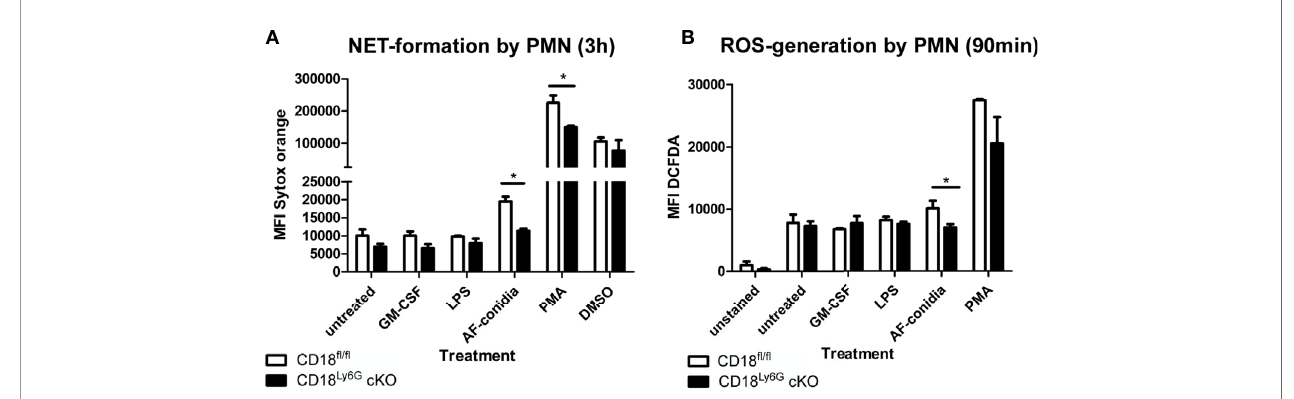
FIGURE 7 | Impaired oxidative and non-oxidative effector functions of CD18-de fi cient PMN. We could observe that the formation of NET after 3h of incubation (A) and ROS-generation (B) were signi fi cantly lower in PMN derived from CD18 Ly6G cKO mice, particularly after stimulation with A. fumigatus conidia. Data represent the mean ± SEM of 3 samples analyzed/group. Statistically signi fi cant differences between groups are indicated (*p<0.05)